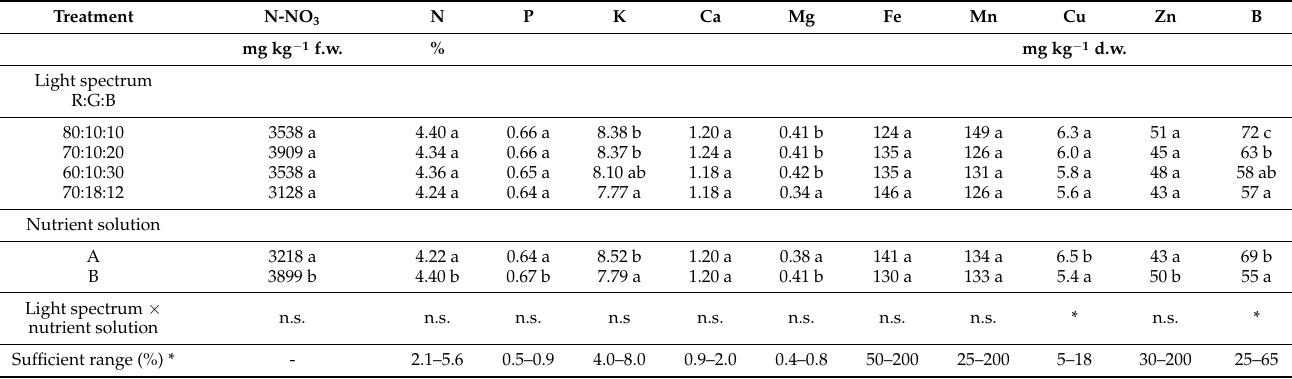
Light spectrum × nutrient solution Sufficient range (%) * Means followed by the same letter are not significantly different ( p < 0.05) using Tukey’s HSD test, ns = not significant, * Sufficient elemental ranges for the most recently matured leaf of greenhouse-grown lettuce, adapted from “Knott’s Handbook for Vegetable Growers”